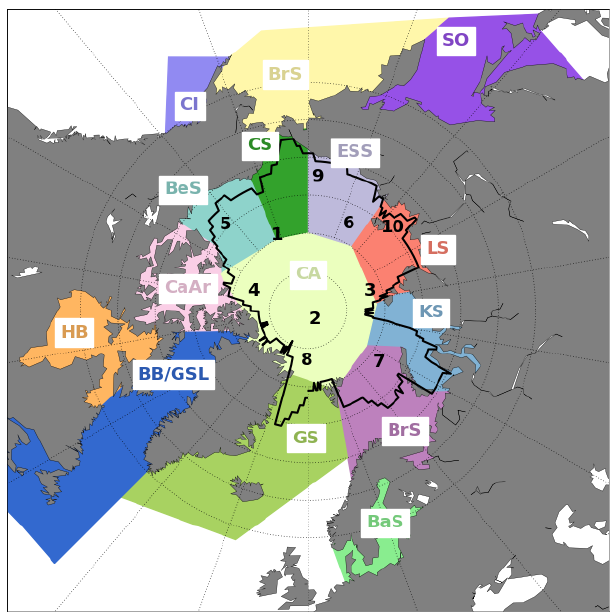
Figure 9. Optimal observing framework for sampling predictor variables in order to statistically reconstruct and/or predict the pan- Arctic SIV anomaly. The numbers indicate the first up to the 10th optimal sites. Each of the coloured areas represents an Arctic sub- region according to the Arctic subdivision suggested by the Na- tional Snow and Ice Data Center (NSIDC). The black line indicates the global region of influence defined in Fig. 8 (colour-shaded ar- eas). Abbreviations: Beaufort Sea (BeS); Chukchi Sea (CS); East Siberian Sea (ESS); Laptev Sea (LS); Kara Sea (KS); Barents Sea (BrS); Greenland Sea (GS); Baffin Bay/Gulf of St. Lawrence (BeS); Canadian Archipelago (CaAr); Hudson Bay (HB); central Arctic (CA); Bering Sea (BrS); Baltic Sea (BaS); Sea of Okhotsk (SO); Cook Inlet